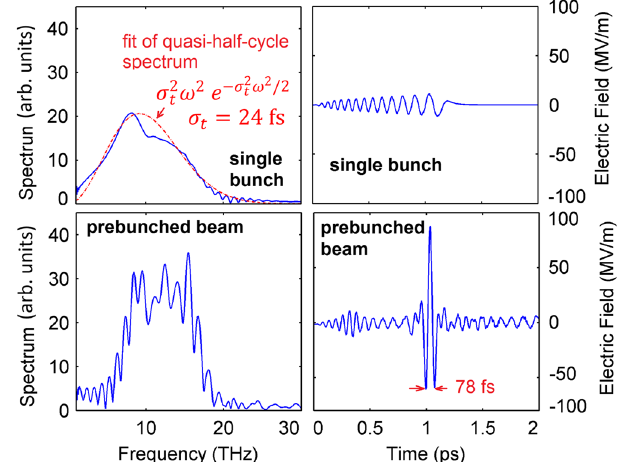
FIG. 8. Top left and top right: On-axis E ω and E ð t Þ generated by a single bunch vs the frequency and time, respectively; bottom left and bottom right: on-axis E ω and E ð t Þ generated by a prebunched beam vs the frequency and time, respectively. FIG. 7. Top left: Density plot of E ω generated by a single bunch as a function of the frequency and normalized radial distance r= σ ; top right: density plot of E ð t Þ generated by a single bunch b as a function of the time and r= σ ; bottom left: E ω generated by a b prebunched beam as a function of the frequency and r= σ ; bottom b right: E ð t Þ generated by a prebunched beam as a function of the time and r= σ . b